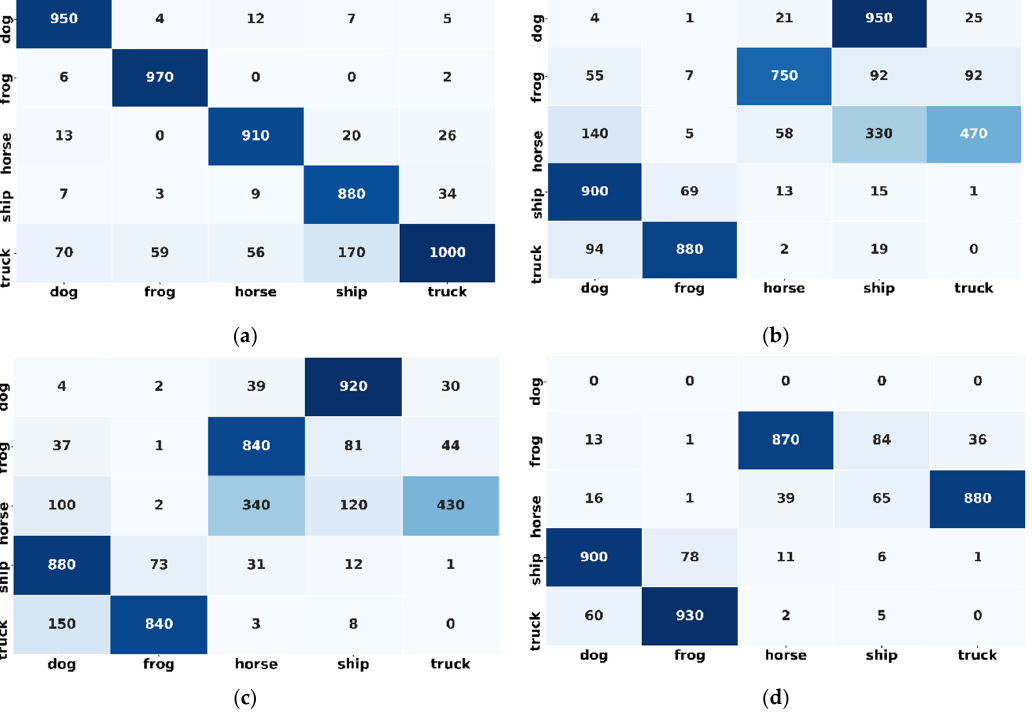
Figure 12. Confusion matrix of proposed framework and state-of-the-art shallow learning and deep learning approaches after novel class arrival issue: ( a ) Confusion matrix for ameliorated adaptive CNN ensemble (proposed framework); ( b ) Ensemble CNN; ( c ) Ensemble Support Vector Machine; ( d ) Random Forest.